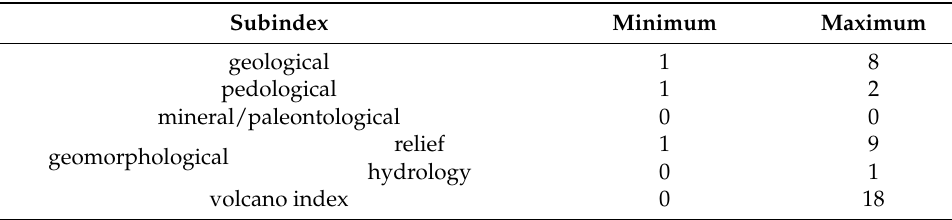
Figure 5. Sectoral division of Puy de Côme ( left panel ) and Puy de la Vache ( right panel ): values represent degrees (median slope angles of each sectors). Table 1. The minimum and maximum values of the various subindices.